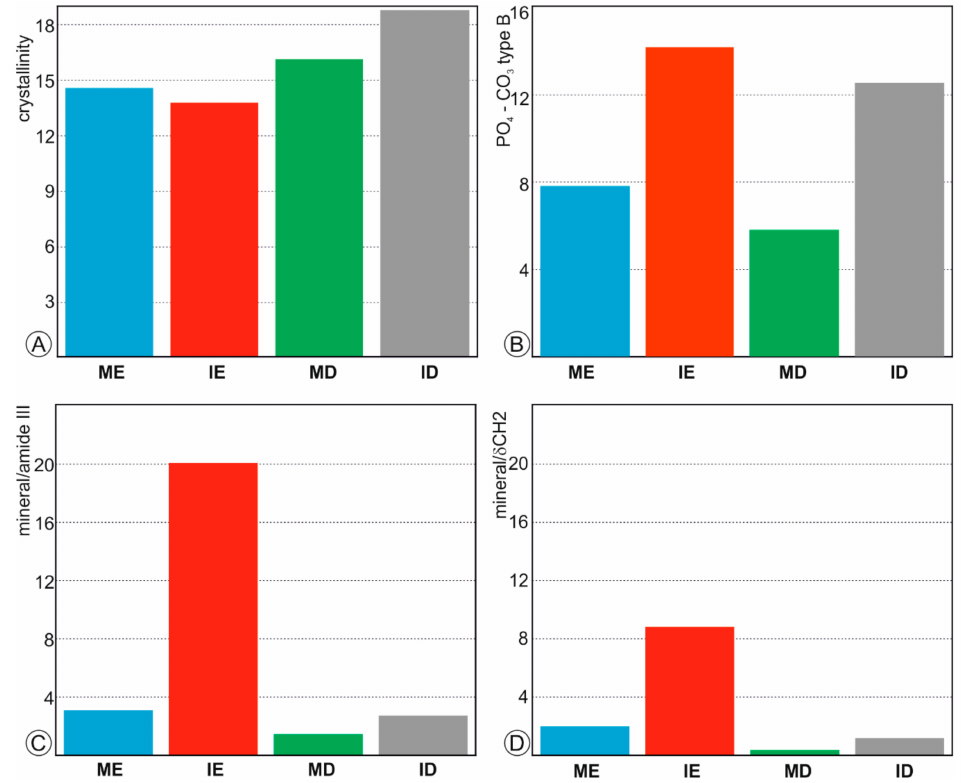
Figure 3. Bulk composition of fresh teeth. ( A )—Crystallinity index calculated from the FWMH of the ν 1 PO 43 − peak. ( B )—Substitution of ions PO 43 − (961 cm − 1 peak) to CO 32 − B type (1070 cm − 1 peak); ( C )—Mineral-organic ratios calculated from the surface of ν 1 PO 43 − divided by the surface of amide III band. ( D )—Mineral-organic ratios calculated from the surface of ν 1 PO 43 − divided by the surface of δ (CH 2 ) band. ME: molar enamel, IE: incisor enamel, MD: molar dentine, ID: incisor